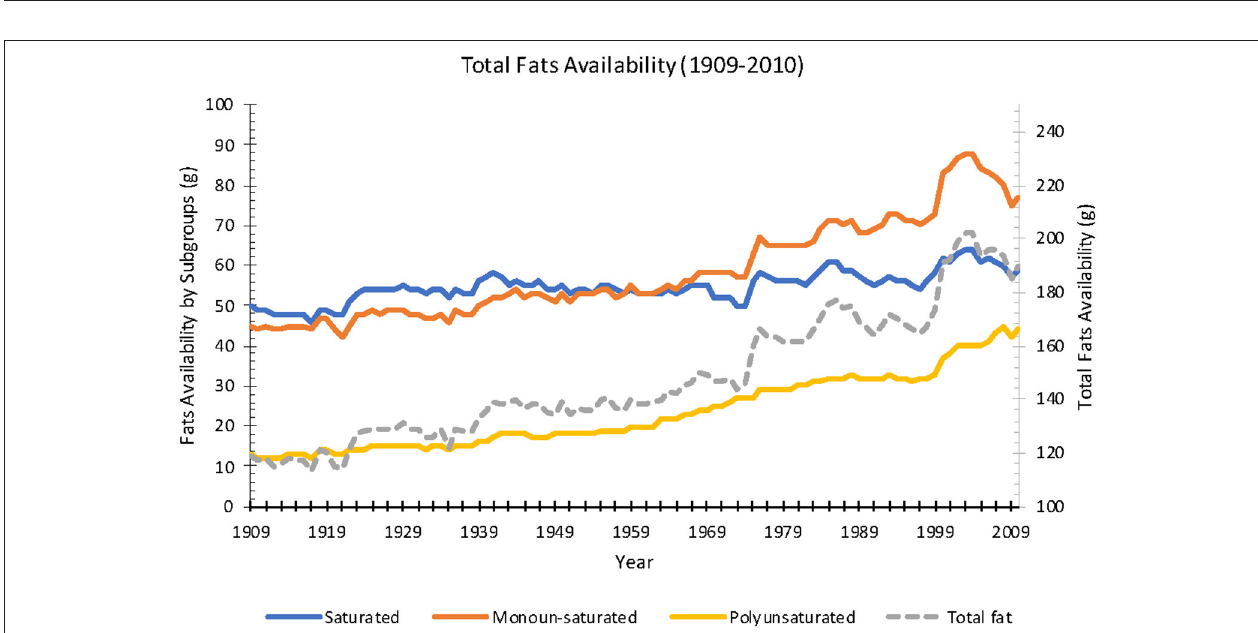
FIGURE 1 | Annual total caloric and macronutrient availability per capita from 1909 to 2010 (Source: USDA ERS ).